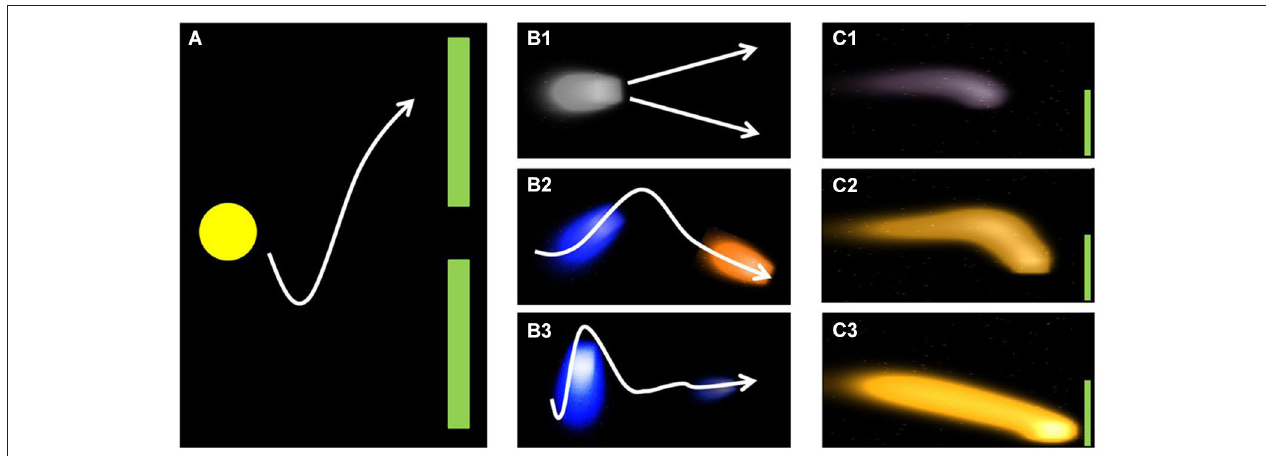
FIGURE 1 | Illustration of classic (A) and fluid (B+C) feedback approach . Figure reproduced from Kaufmann et al. (2011) with permission of the International Journal of